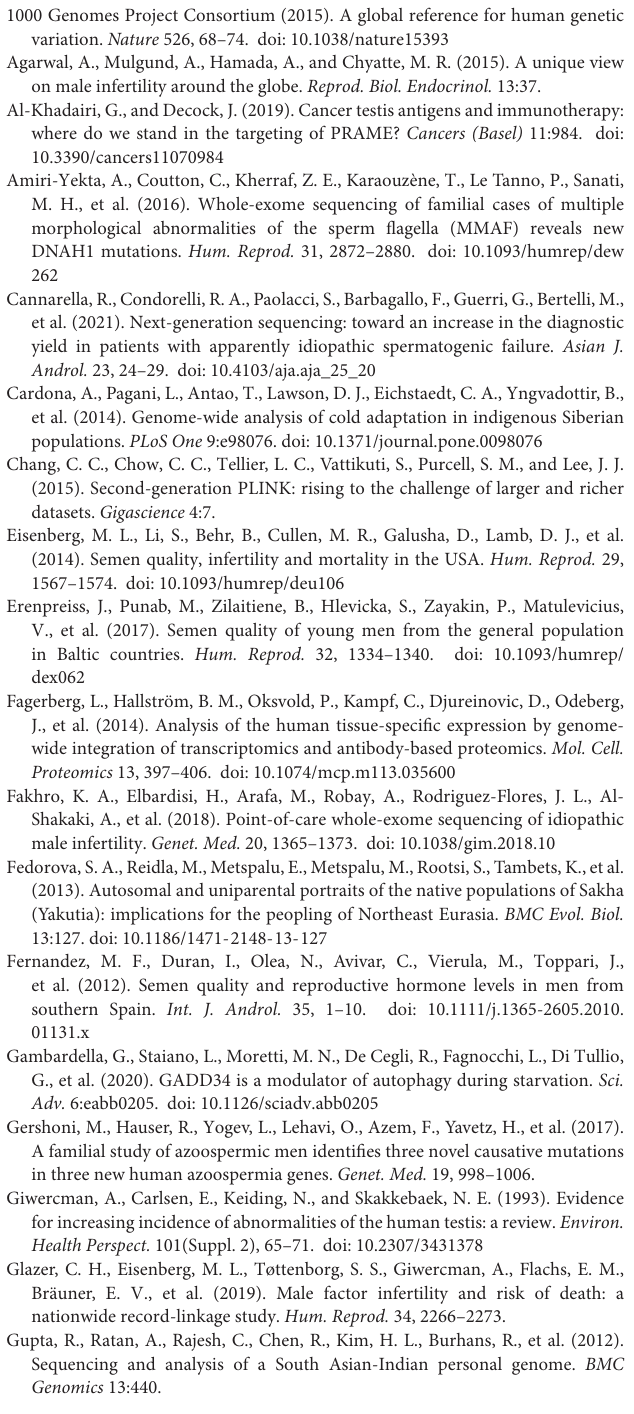
Supplementary File 8 | Top-100 results of association analysis using log-regression model or the Slavic subgroup combined with VEP results, Protein Expression Atlas normalized expression values for genes harboring polymorphisms and genes associated with male infertility from DisGeNET.